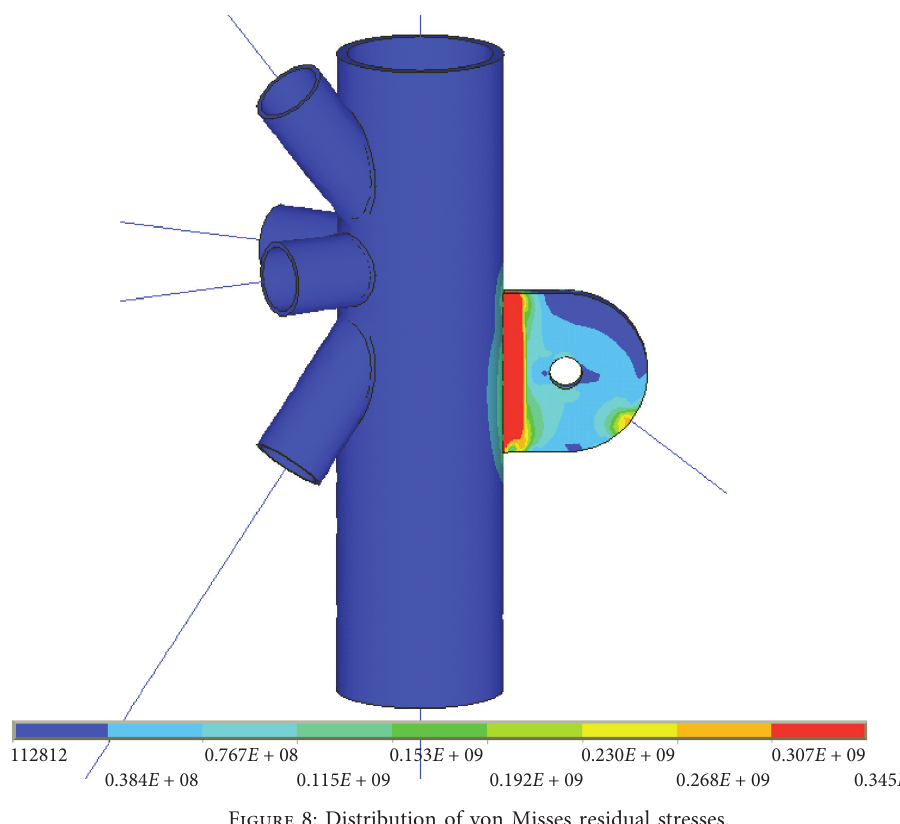
Figure 8: Distribution of von Misses residual stresses.